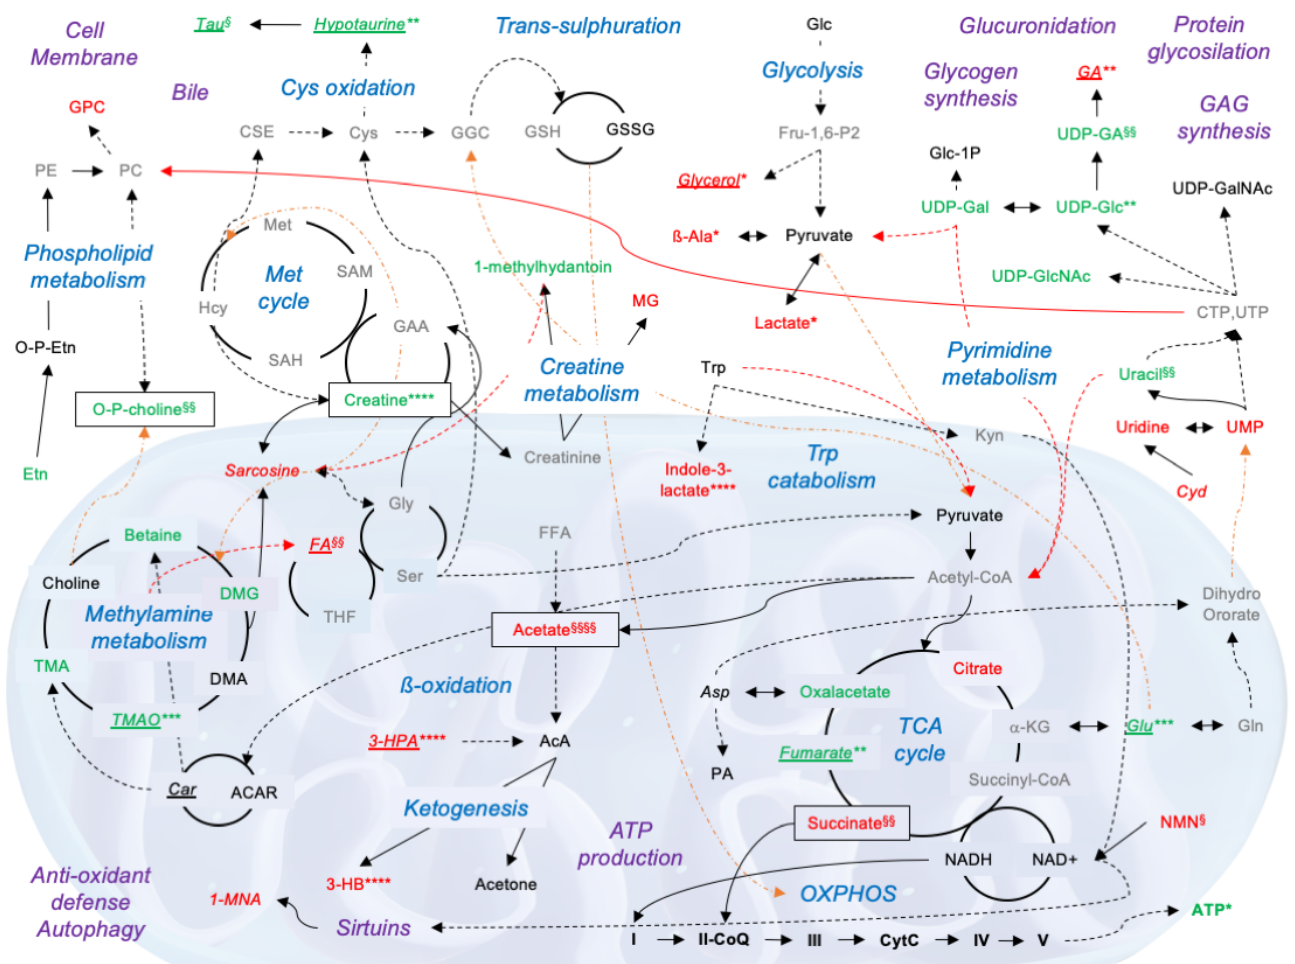
Figure 6. Simplified diagram showing the metabolomic pathways modulated during normother ‐ mic machine perfusion (NMP) and their interactions. Metabolites typed in red fonts are upregu ‐ lated in the NMP groups compared to the Native group, while those typed in green fonts are down ‐ regulated. Metabolites typed in black fonts had a similar concentration across ex vivo perfused and native livers. Metabolites detected only in perfusate sample are typed in italics, those detected only in bile samples are in italics and underlined. Metabolites which were undetectable by NMR ‐ based spectroscopy are indicated in gray fonts. Differences across experimental groups were investigated by one ‐ way ANOVA, followed by Tukey’s post hoc test. p ‐ values are indicated as follows: all the NMP groups vs. Native: * p < 0.05; ** p < 0.01; *** p < 0.001, **** p < 0.0001; only OxC ‐ NMP vs. Native: § p < 0.05; §§ p < 0.01; §§§§ p < 0.0001. Black arrows indicate a direct relationship between two me ‐ tabolites; black dotted arrows denote multiple enzyme reactions to convert one metabolite into an ‐ other; red arrows link one specific metabolic pathway to a different pathway; orange dotted arrows indicate metabolite translocation from mitochondria to cytoplasm and vice versa . Adapted from KEGG reference pathways. Abbreviations: I, NADH dehydrogenase; II, NADH dehydrogenase; III, cytochrome C reductase; IV, cytochrome C oxidase; V, ATP synthase; 1 ‐ MNA, 1 ‐ methylnicotina ‐ mide; 3 ‐ HB, 3 ‐ hydroxybutyrate; 3 ‐ HPA, 3 ‐ hydroxyphenylacetate; α‐ KG, α‐ ketoglutarate; AcA,